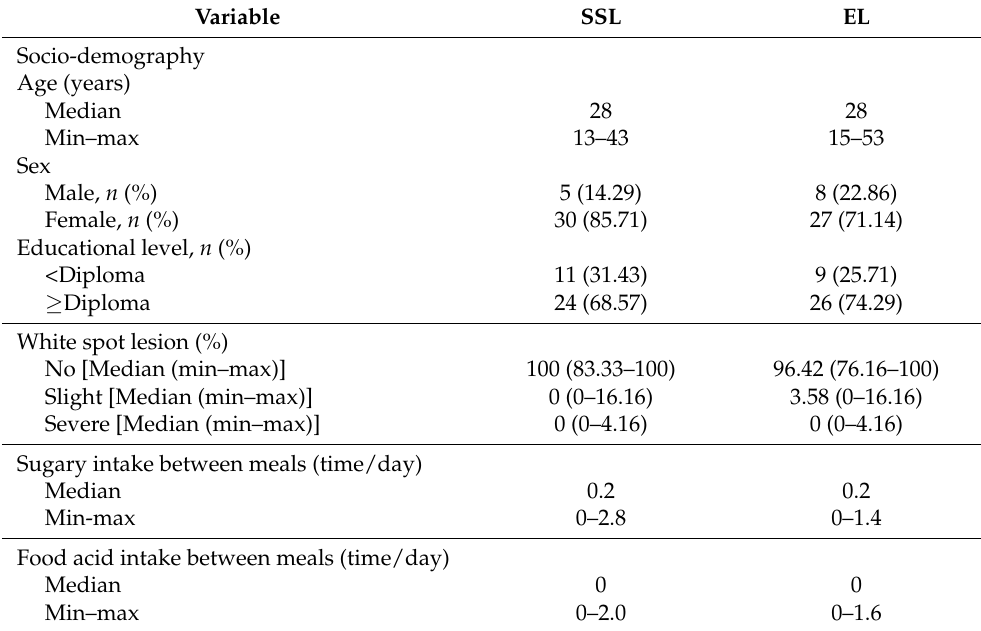
Table 1. Distribution of the sociodemographic, WSL, and dietary habit data based on ligature type at